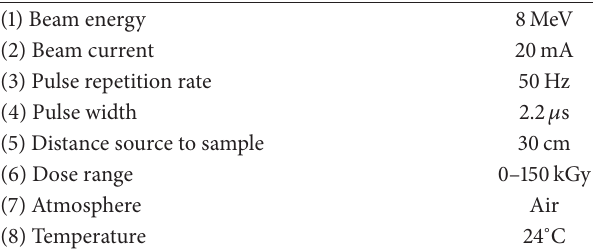
Table 1: Specifications of the electron beam accelerator and irradi- ation conditions.